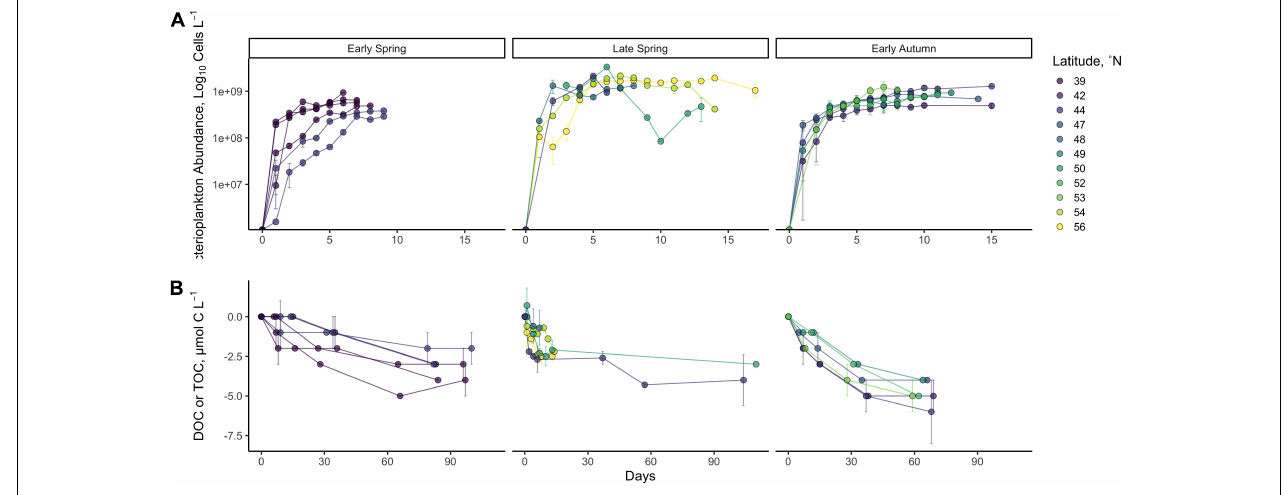
FIGURE 3 | Time series of station mean log 10 cell abundance (A) and DOC/TOC (B) from DOC remineralization experiments. Data represent the change in bacterioplankton log 10 cell abundance from T 0 up to 17 days or change in DOC concentration throughout the long-term incubation of up to 110 days. Late-spring organic carbon data are from filtered DOC samples, while early spring and early autumn organic carbon data are from unfiltered TOC samples. Error bars indicate the standard deviation between the means of replicated